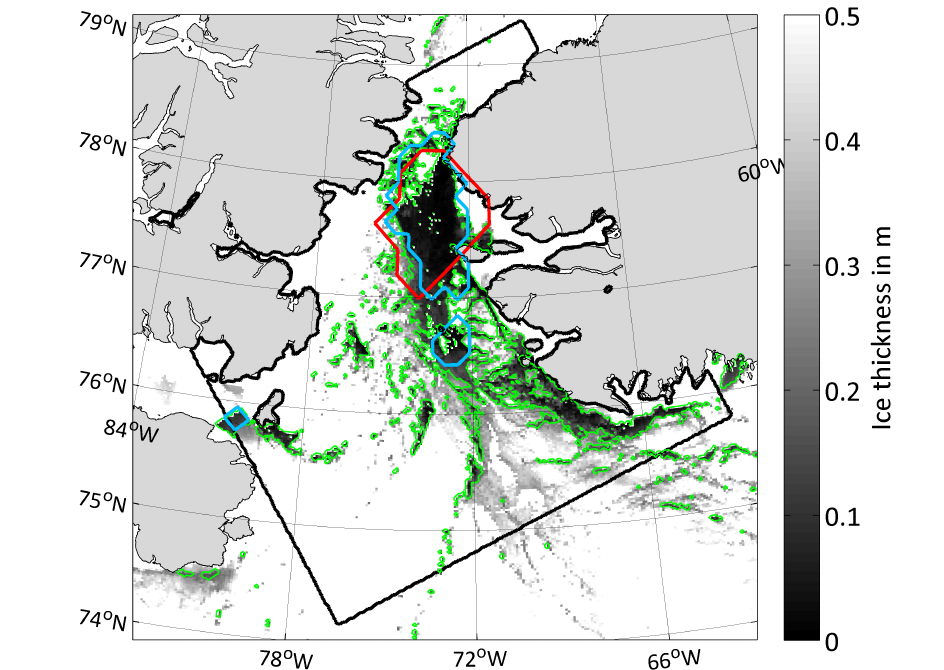
Figure 2. MODIS thin-ice thicknesses (TIT up to 0.5 m) on 14 March 2009, 1055UTC. The black boundary marks the applied polynya mask, while the sensor-specific retrieved POLA is indicated by colored contours for MODIS (TIT ď 0.2 m; green contour; 2 km), SSM/I 70PT (red contour; 25 km) and SSM/I PSSM (light-blue contour; 12.5